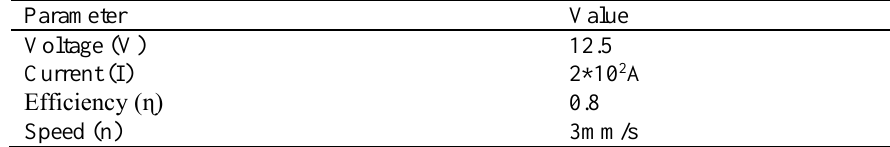
Table 2. Parameters considered during GTAW